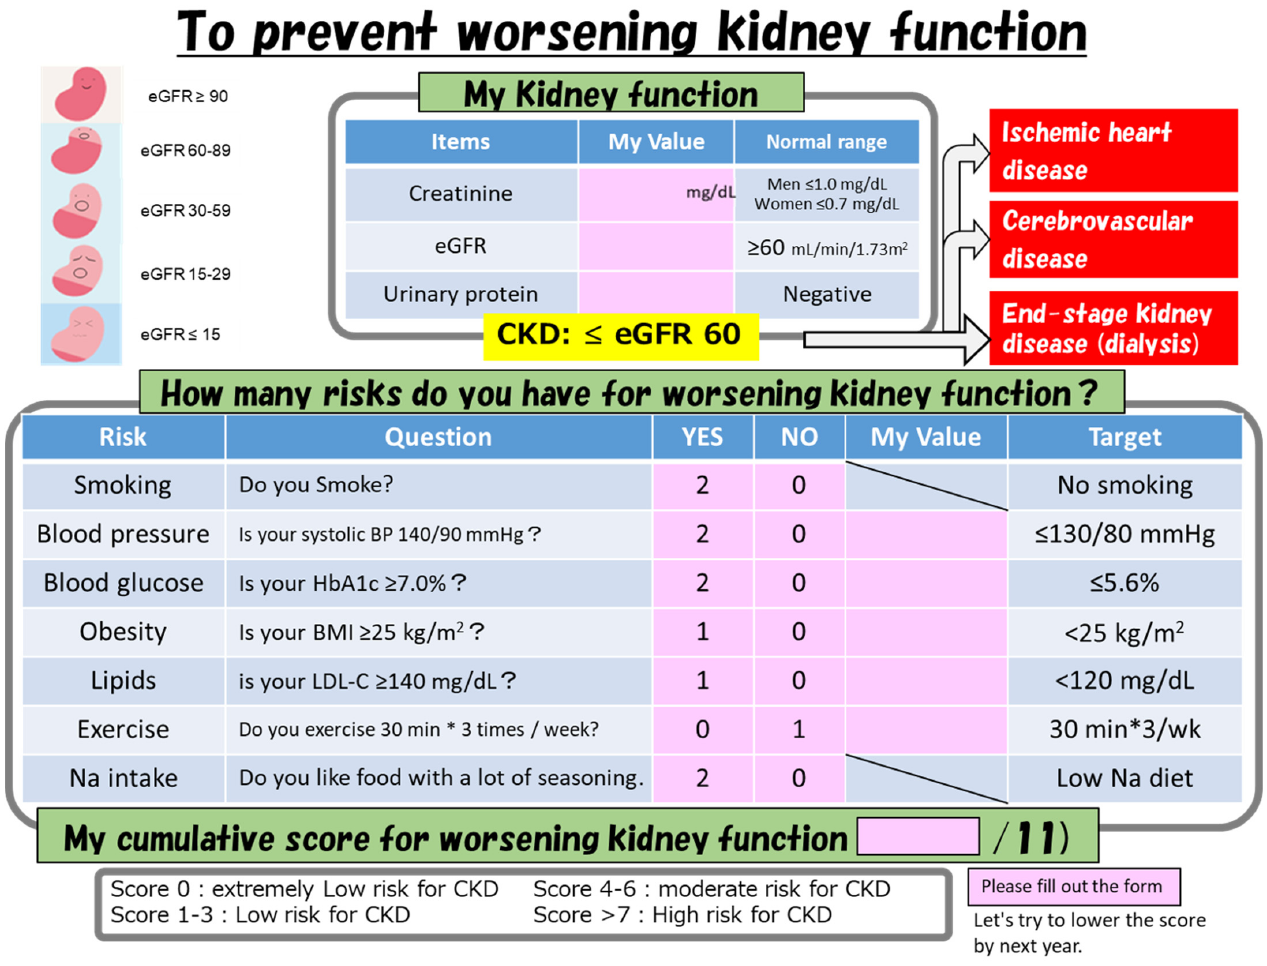
Figure 1. Risk factor list chart for CKD used in the participatory structured group education program: eGFR, estimated glomerular filtration rate; Na, sodium; BP, blood pressure; HbA1c, glycated hemoglobin; BMI, body mass index; LDL-C, low-density lipoprotein cholesterol; CKD, chronic kidney disease.